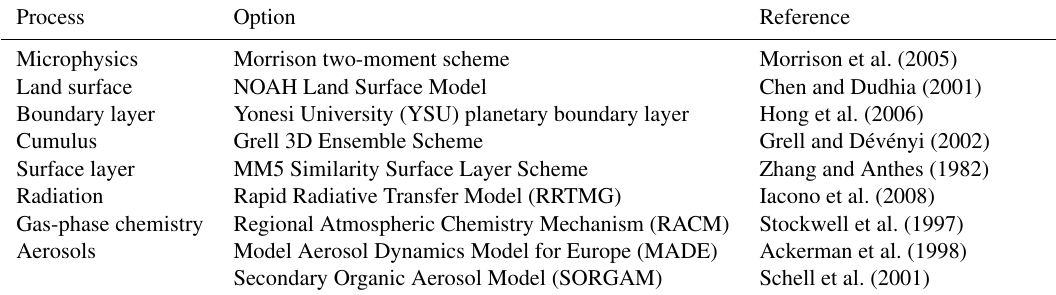
Table A1. WRF-Chem model configuration options used in the